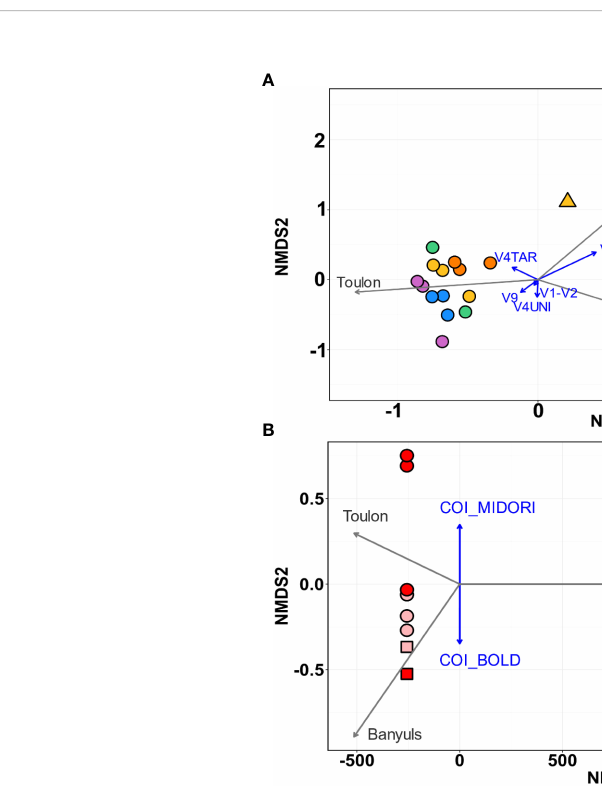
FIGURE 7 NMDS showing eukaryotic communities that attached to PVC panels at the three sites (Banyuls, Toulon, Saint-Nazaire showed by different shapes) with primers targeting (A) the fi ve regions of 18S rDNA (colors) and (B) the COI with two databases (MIDORI and BOLD). Jaccard ’ s distance was used for the raster distance. The gray vectors represent the sites, and the blue vectors represent the primers, or, in the case of COI, the databases used (envit function). Each point represents one